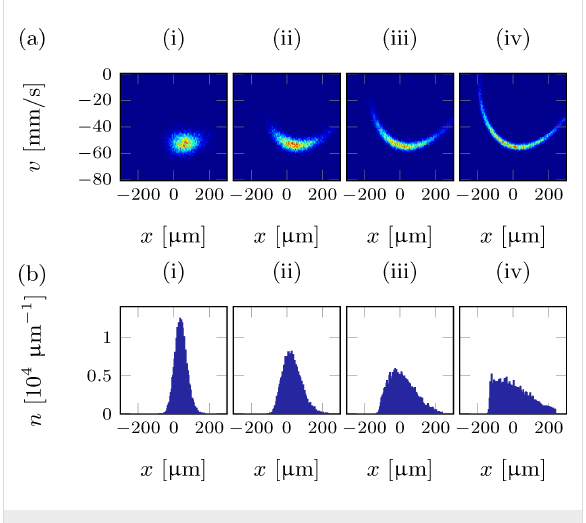
Figure 2: Numerical simulation of an oscillating cold-atom tip in an anharmonic potential of fundamental period T = 1/(50 Hz) and anhar- monicity ε = 2 × 10 8 m − 1 s − 2 : (a) phase-space density and (b) density profiles at times t = 0.25 T, 2.25 T, 4.25 T, 6.25 T (i–iv) after the initial tip displacement. Particle interactions (collisions) are not taken into account.